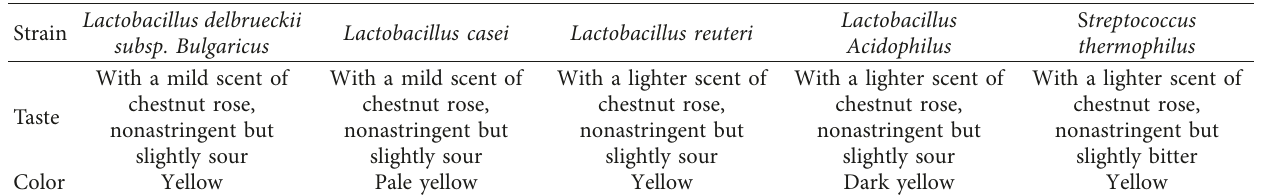
Table 7: Sensory performance of jiaosu under fermentation with different strains of bacteria.